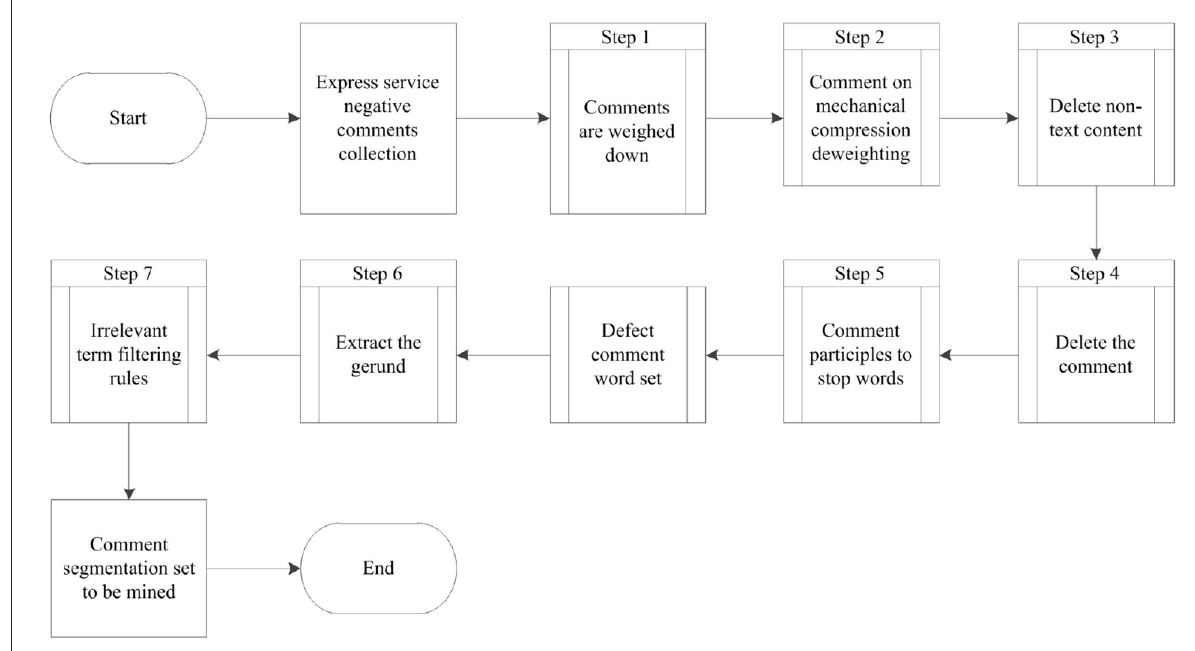
FIGURE3 Processing process and result of negative comment set of express service.